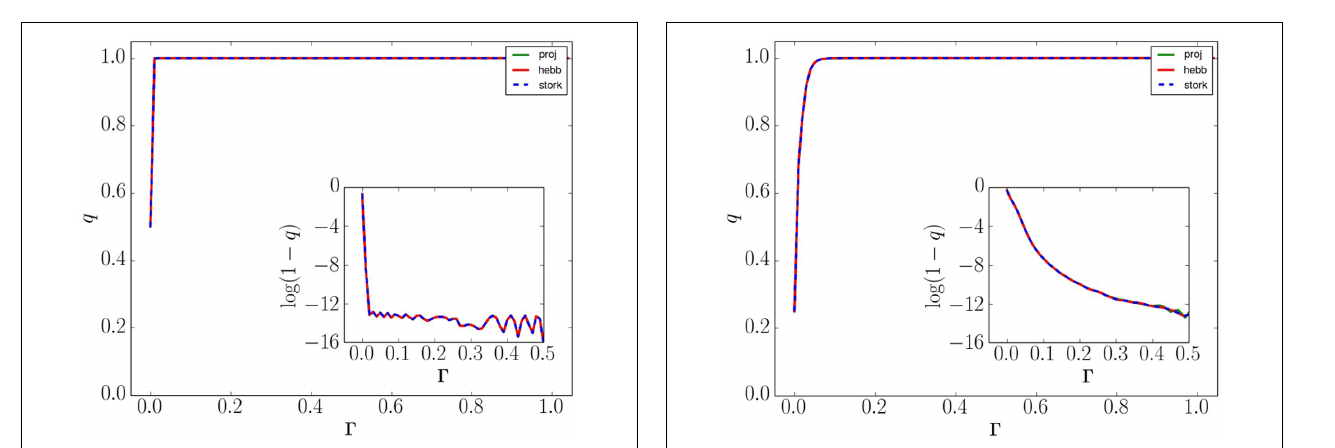
FIGURE 3 | Probability q to recall the correct memory with respect to applied bias (cid:3) for n = 4 neurons and p = 1 memory from the set in Equation (23). All three learning rules coincide in behavior and provide unit recall success for any amount of applied bias. Inset: a semi-log plot showing how recall error decreases with applied bias. Numerical noise dominates the inset plot beyond (cid:6) ≈ 0 . 02